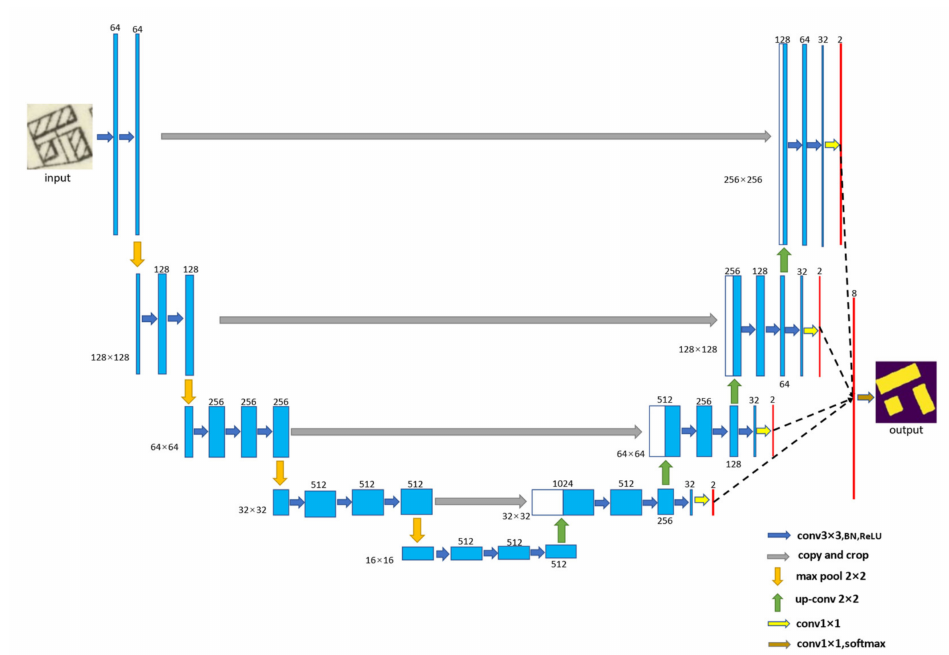
Figure 4. Structure of